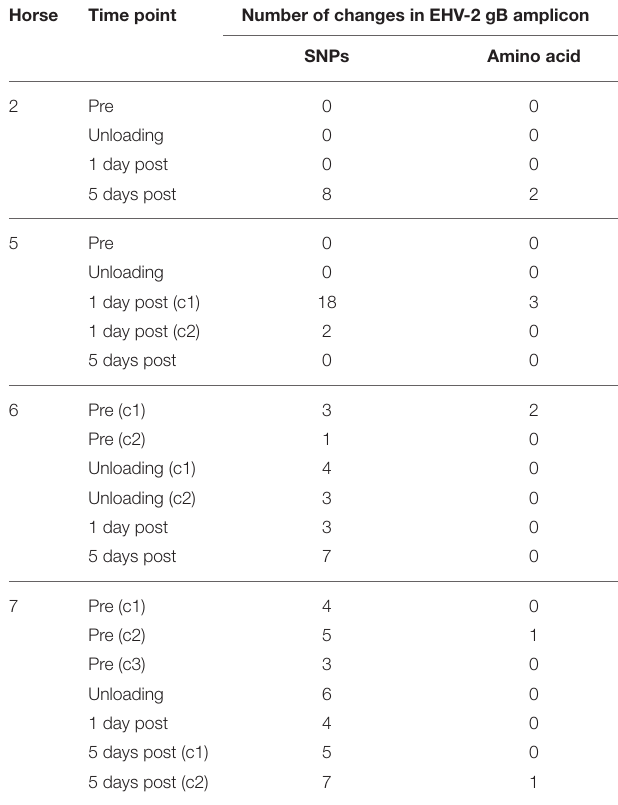
TABLE 2 | Genetic variation of EHV-2 sequences isolated from 4 individual horses, displayed as number of changes compared with the consensus sequence within each